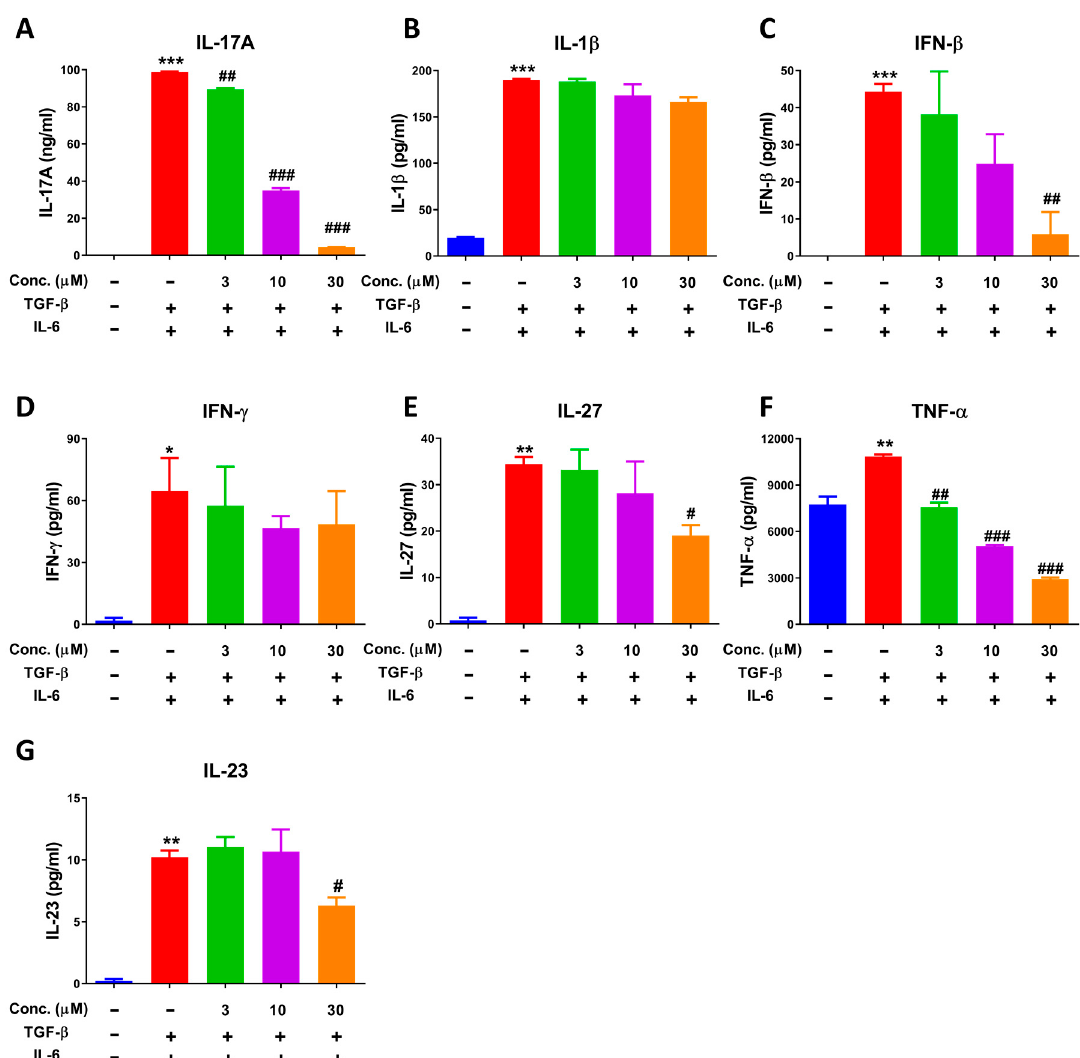
Figure 6. Effect of NEO on cytokines in the process of Th17 cell differentiation. ( A – G ) Impacts of NEO on individual cytokines levels. * p < 0.05, ** p < 0.01 and *** p < 0.001 indicated that the differences were statistically significant vs. control group; whereas, # p < 0.05, ## p < 0.01 and ### p < 0.001 declared statistically significant differences vs. TGF- β and IL-6 group (n = 3).